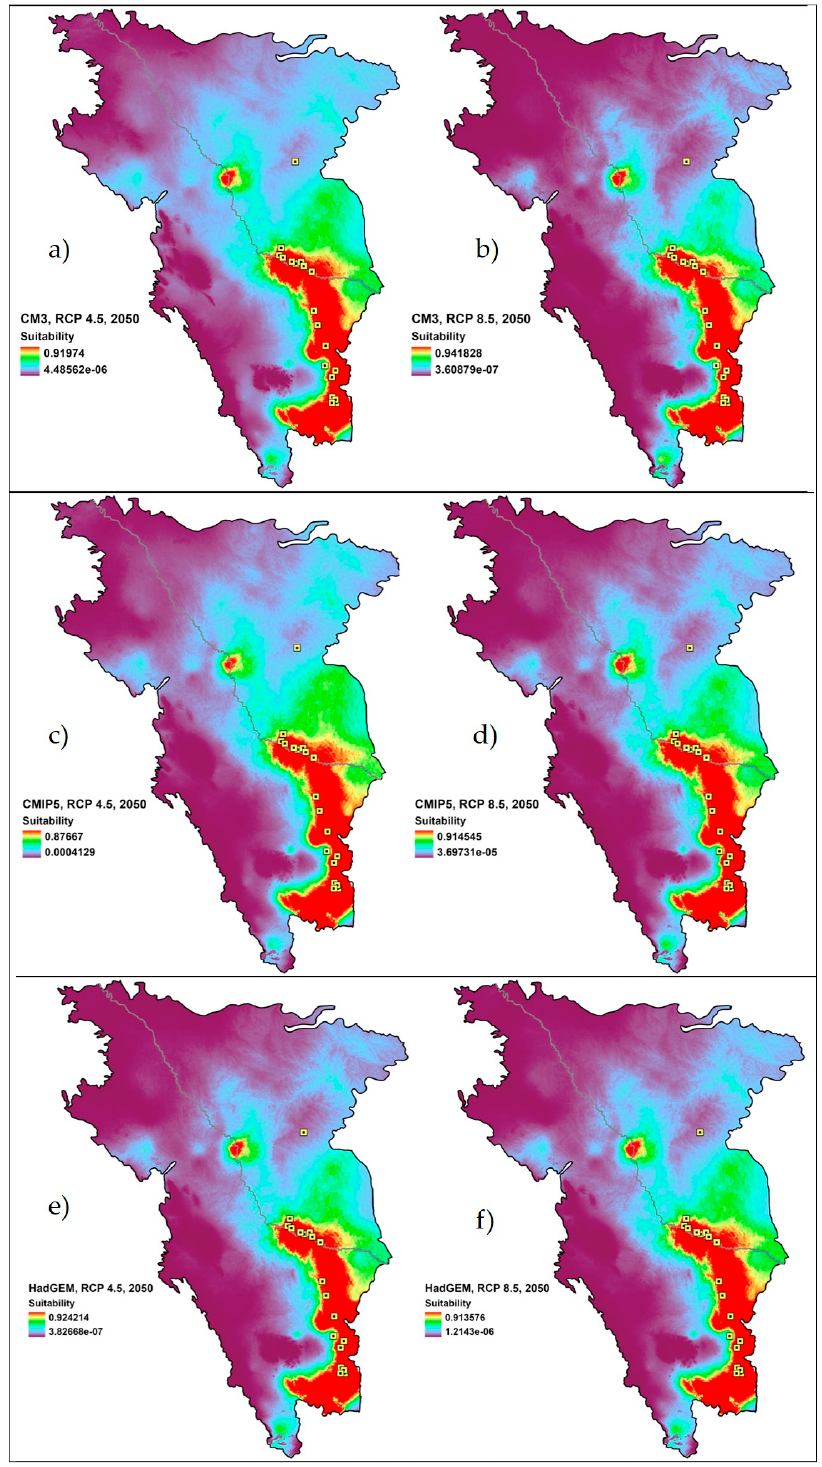
Figure 3. Future potential geographic distribution for M. walkerae for the year 2050 using ten bioclimatic variables and nineteen spatially rarefied occurrences. Panels ( a ) and ( b ) correspond to the CM3 GCM at an RCP of 4.5 and 8.5, respectively. Panels ( c ) and ( d ) correspond to the CMIP5 GMC at an RCP of 4.5 and 8.5. Panels ( e ) and ( f ) correspond to the HadGEM GMC at an RCP of 4.5 and 8.5.